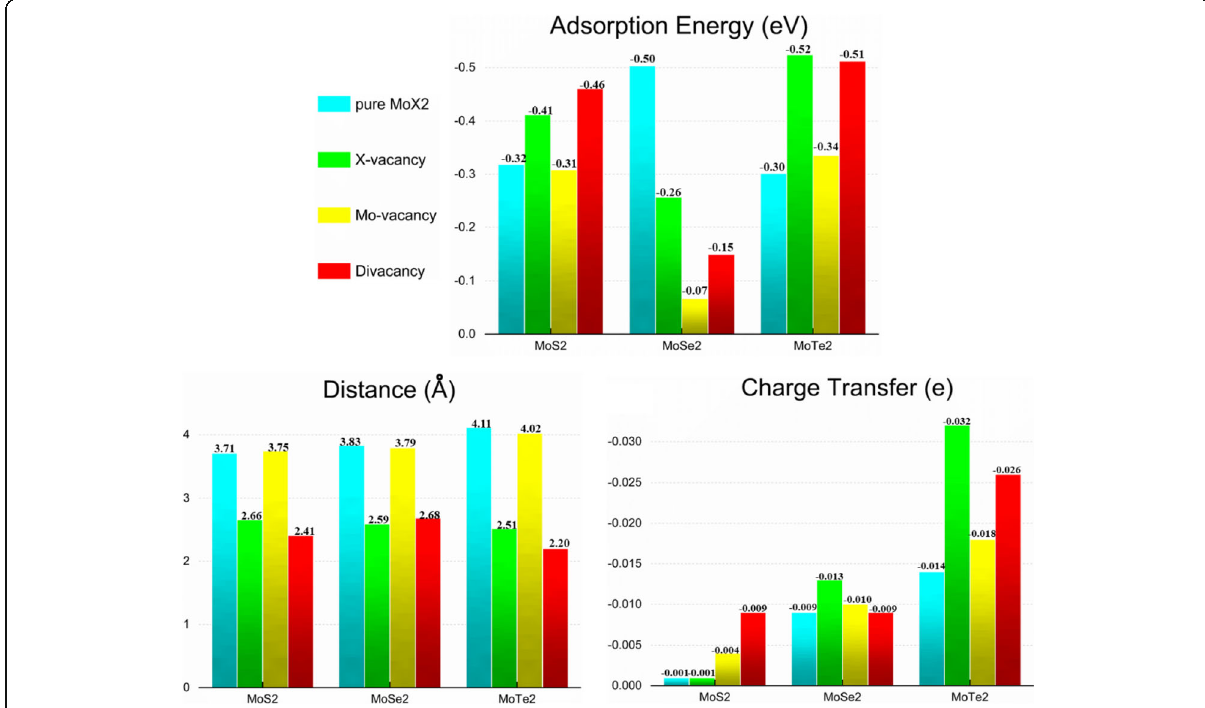
Fig. 3 Adsorption energies, shortest atomic distances between molecule and MoX 2 , and charge